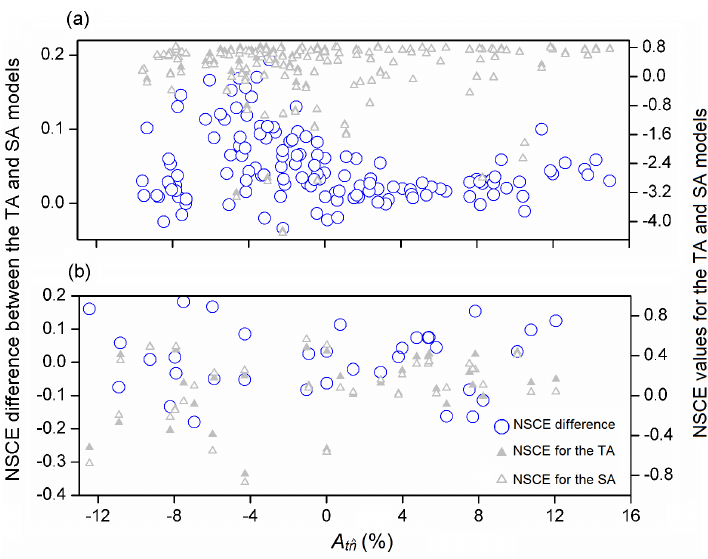
Figure 10. Nash–Sutcliffe coefficient of efficiency (NSCE) difference between the TA and SA models in terms of soil water content estima- tion using cross-validation as a function of space-invariant temporal anomaly A t ˆ n for (a) 0–0.06m of the Chinese Loess Plateau hillslope and (b) 0–0.15m of the GENCAI network in Italy. The NSCE values for both models are also